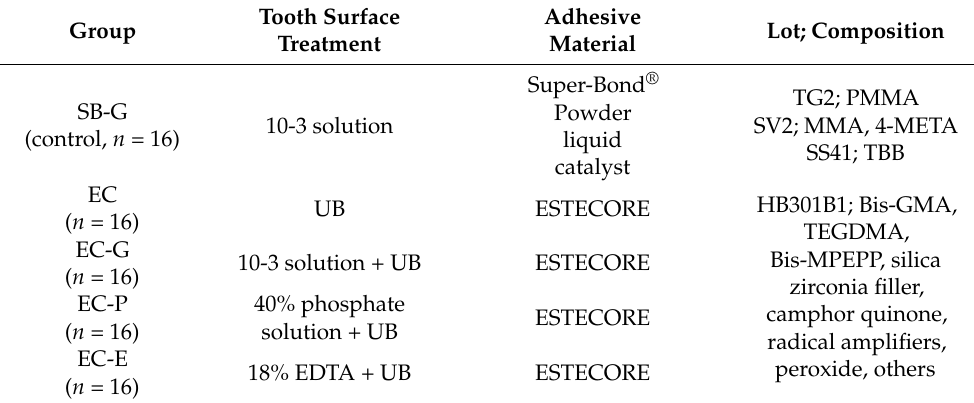
Table 1. Experimental groups in this